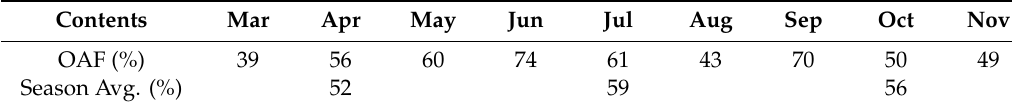
Table 4. Monthly average outdoor air fraction (OAF) in the case study.